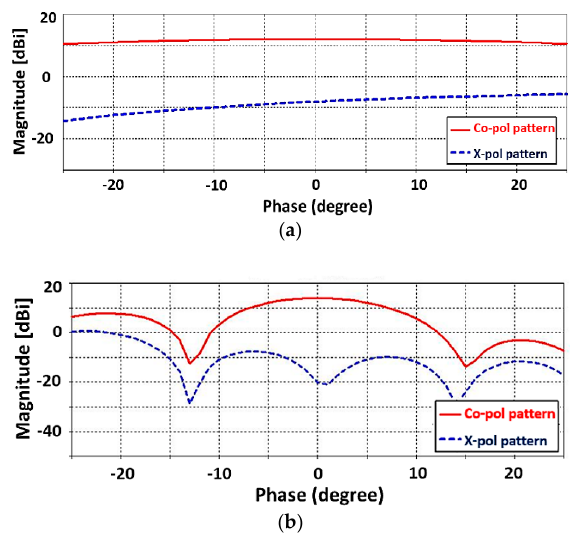
Figure 24. Co- and cross-pol performances of Vivaldi antenna array with four-way SIW power divider at 23 GHz, ( a ) H-plane, ( b ) E-plane.